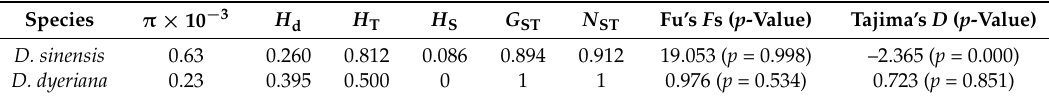
Table 3. Genetic diversity, differentiation parameters, and neutrality test in all populations of D. sinensis and D. dyeriana .